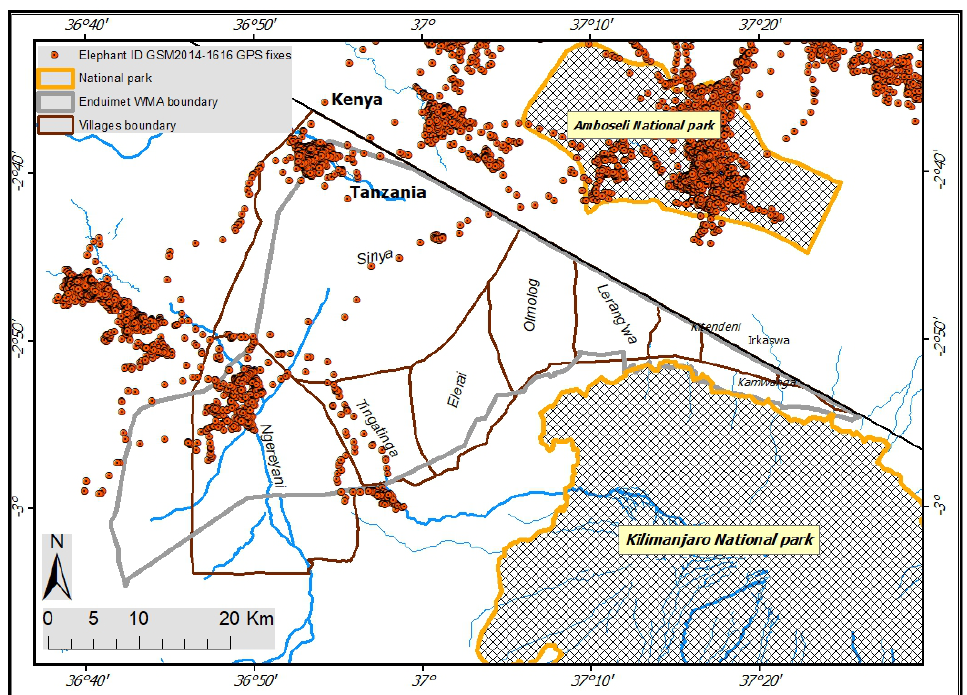
Figure A1. Spatial distribution of one collared elephant with the ID GSM2014–1616 ( n = 17,452) in